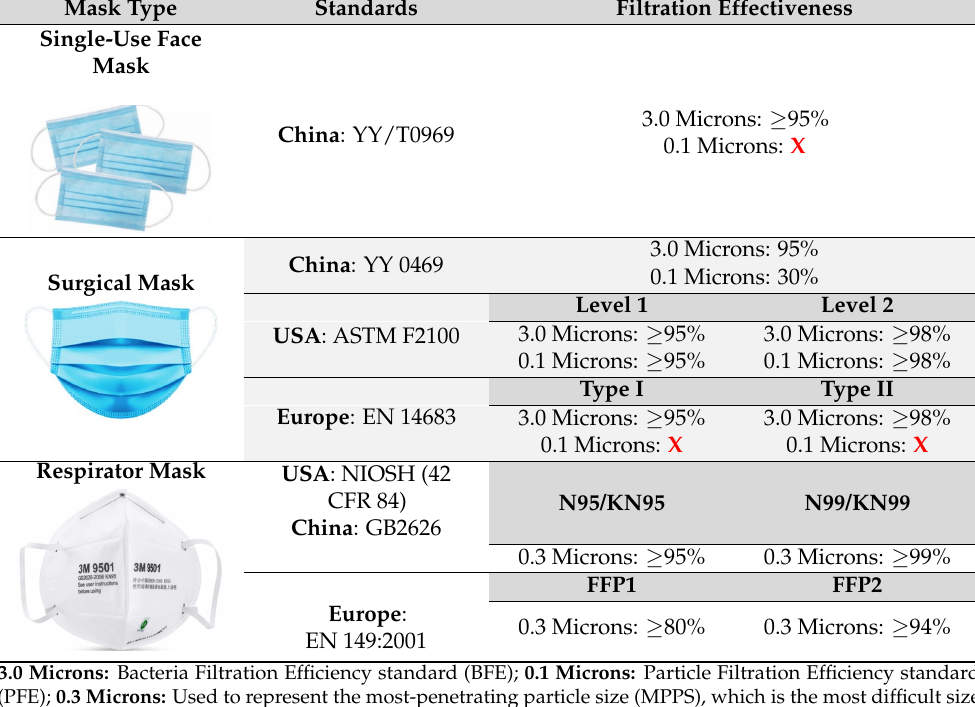
Table 1. Comparison of mask standards, ratings, and filtration effectiveness [42].